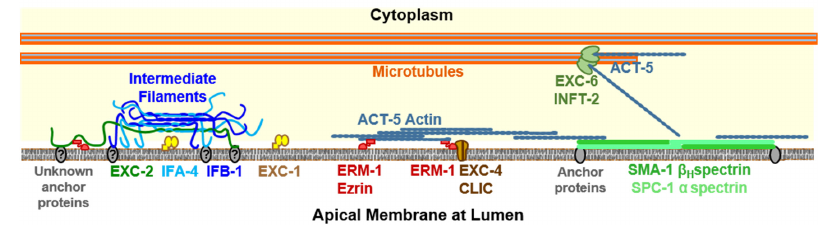
Figure 3. Diagram (not to scale) of cytoskeletal elements at the excretory canal apical membrane. Microtubules are located both near and far from the apical membrane. Note that not all locations and interactions have been proven to occur within the excretory canals of C. elegans . Tips of microtubules are located at organizing centers, where formin EXC-6 (and possibly formin INFT-2) nucleate actin filaments both along the length of the canal and towards its apical surface [55]. Fibers of ACT-5 actin are held close to the apical surface and organized there through interactions with the β -heavy spectrin SMA-1 [30,31,56] (presumably anchored by the Band 4.1 homologue FRM-1 [57]) and with the ezrin / radixin / moesin homologue ERM-1 [22,29,58]. In mammals, intracellular chloride channel (CLIC) channels homologous to EXC-4 are also associated with ezrin [59]. Intermediate filaments are associated with the luminal membrane by unknown anchor proteins, though spacing of these filaments depends on ERM-1 and SMA-1 [22,29]. The intermediate filaments associate by their central filament domain to form heterologous filaments that extend farther from the membrane than do the bulk of the apical actin filaments [60]. EXC-1 is another protein a ff ecting canal structure located exclusively at the apical membrane